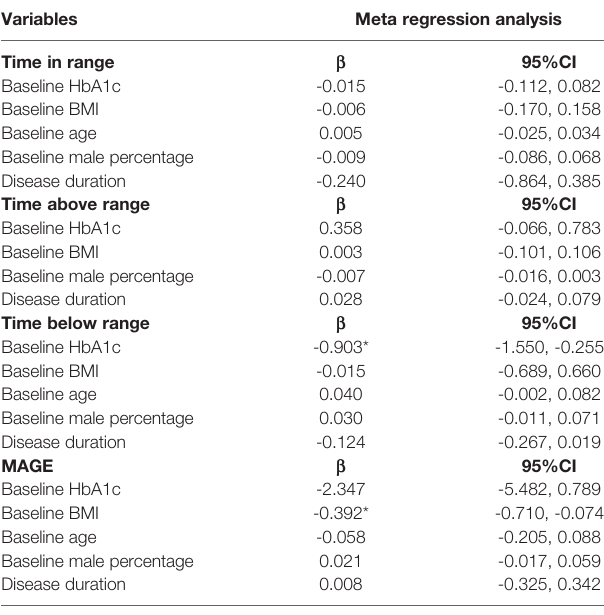
TABLE 3 | Meta-regression analysis for the associated factors and change in TIR, MAGE, TAR, and TBR.